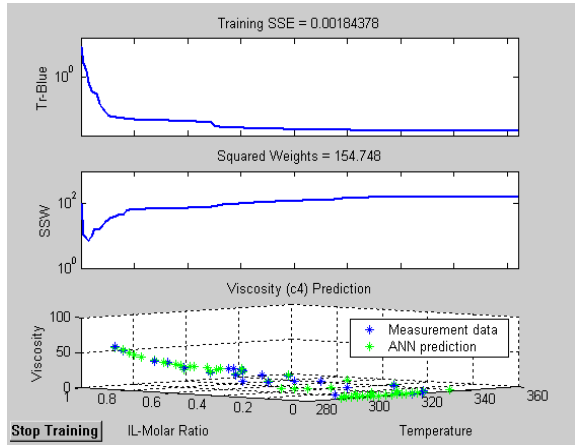
Fig. 5.2. Viscosity for [C 4 -mim][NTf 2 ]-ethanol binary mixtures at the temperature range T=293-328K in terms of different molar ratios.